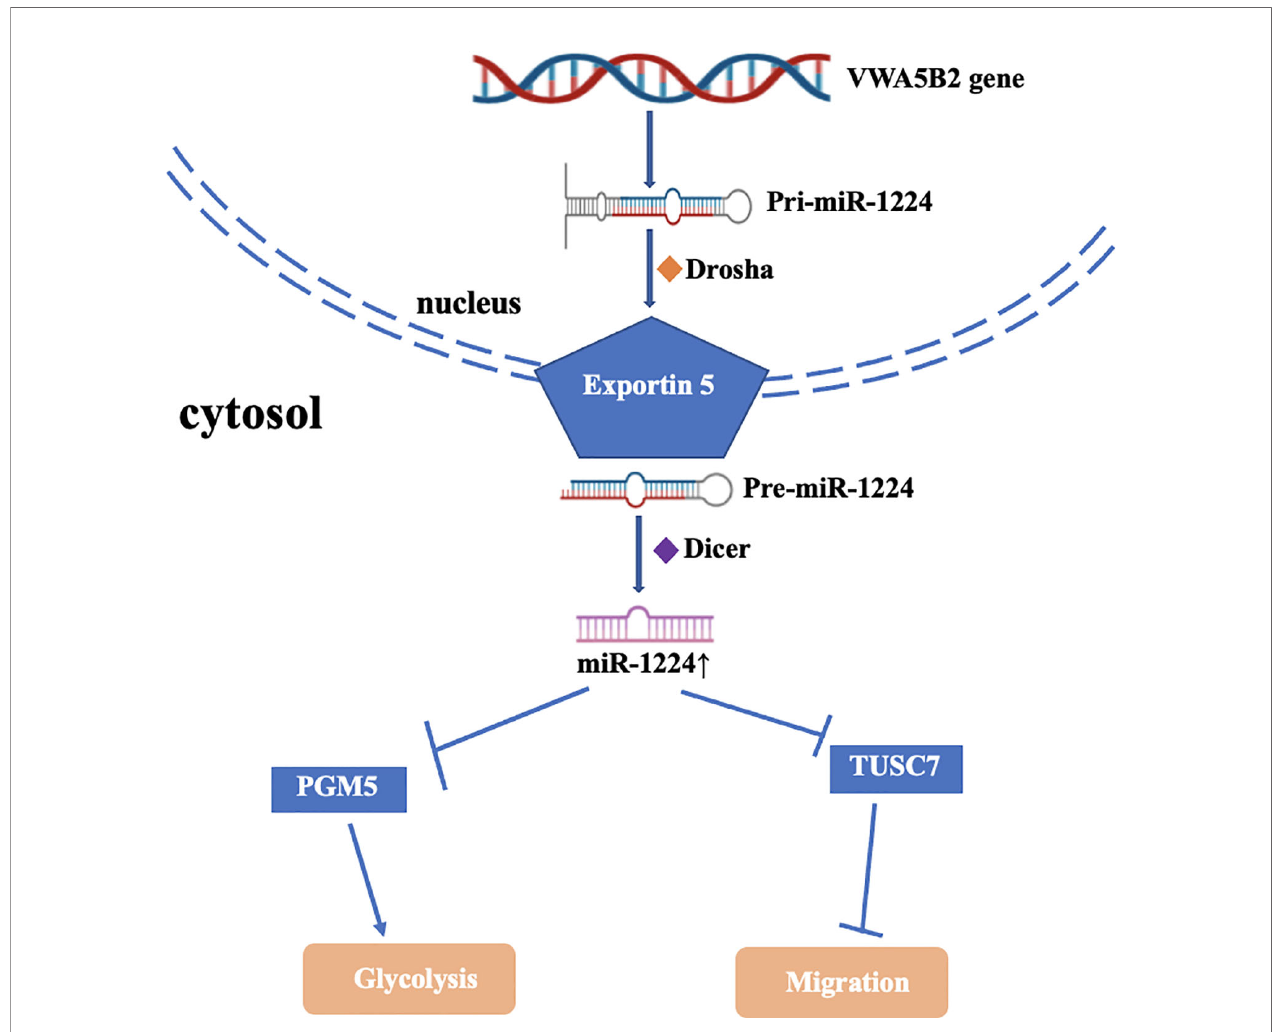
FIGURE 2 | Mechanism and function of miR-1224 upregulation in